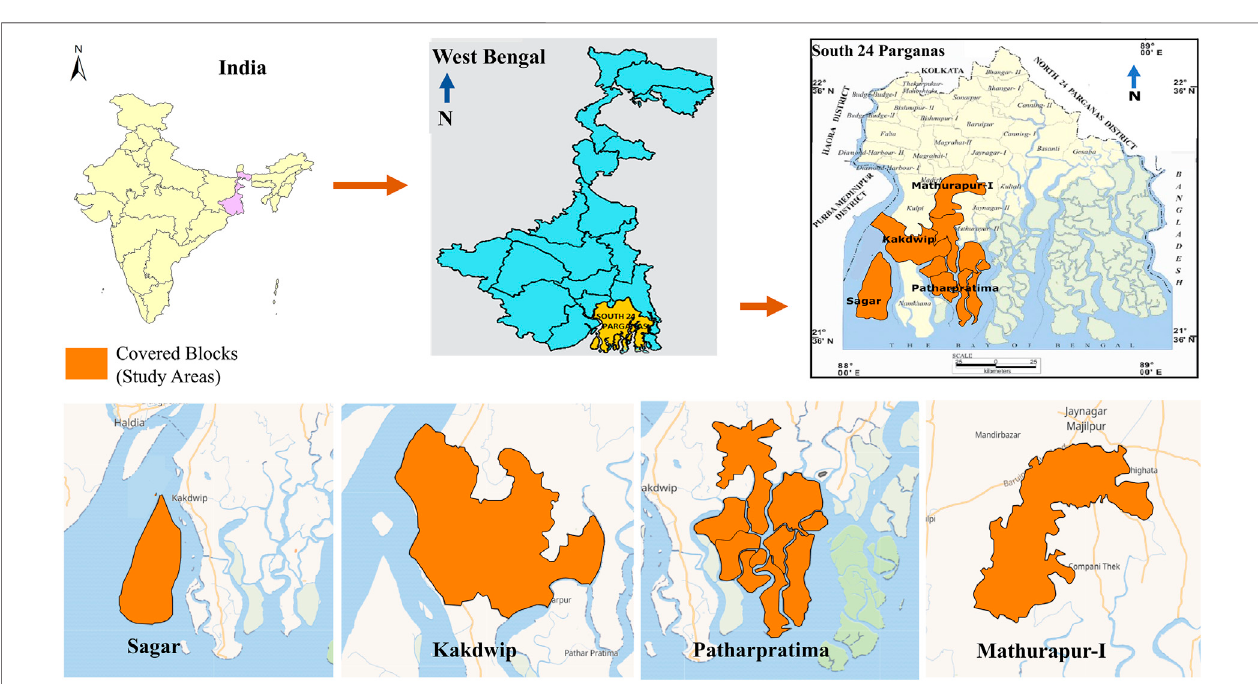
FIGURE 2 | Location maps of the study